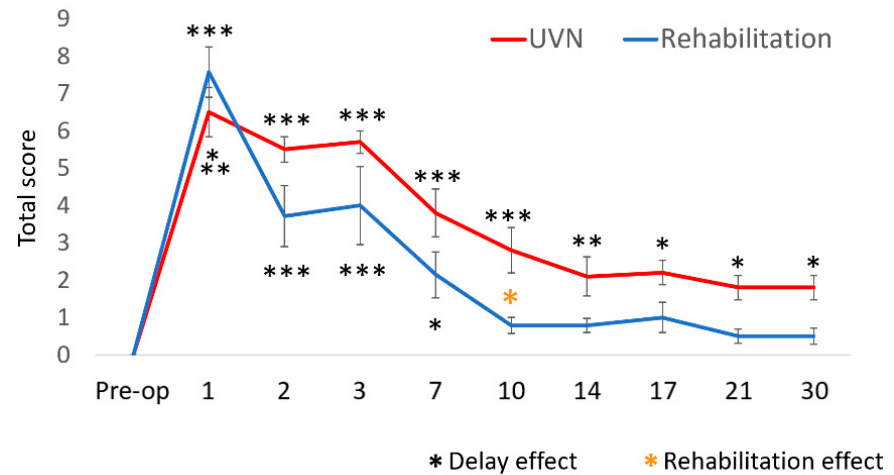
Figure 2. Use of a cumulative qualitative scale for the assessment of vestibular syndrome in the UVN and rehabilitation groups. For both groups, we can observe a critical period where the disorders were at their maximum from D1 to D3 and then a compensated period where the disorders gradually decreased from D7 to D30. The posturolocomotor disorders remained present in the UVN group, while they seemed to disappear in the rehabilitation